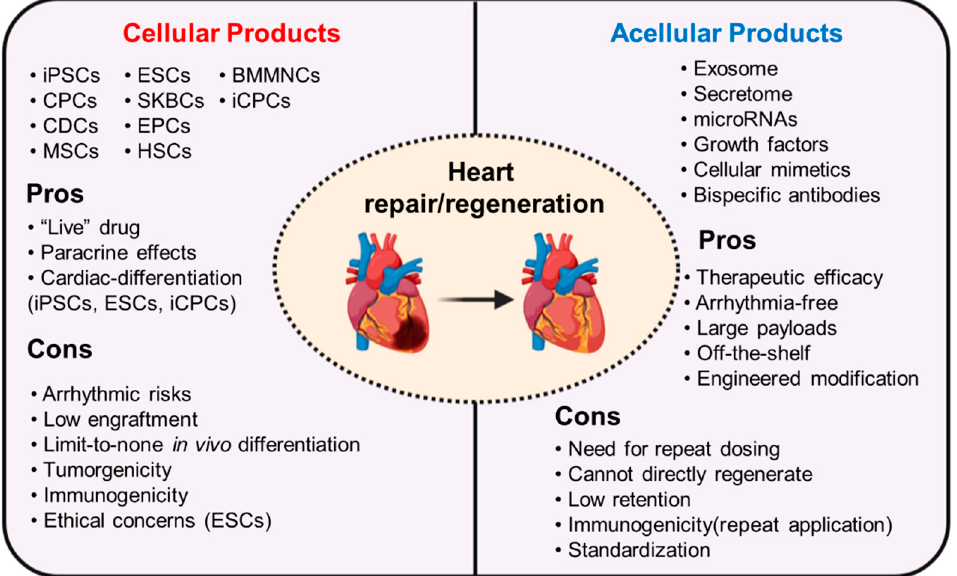
Figure 5. The advantages and disadvantages in cellular and acellular therapy.